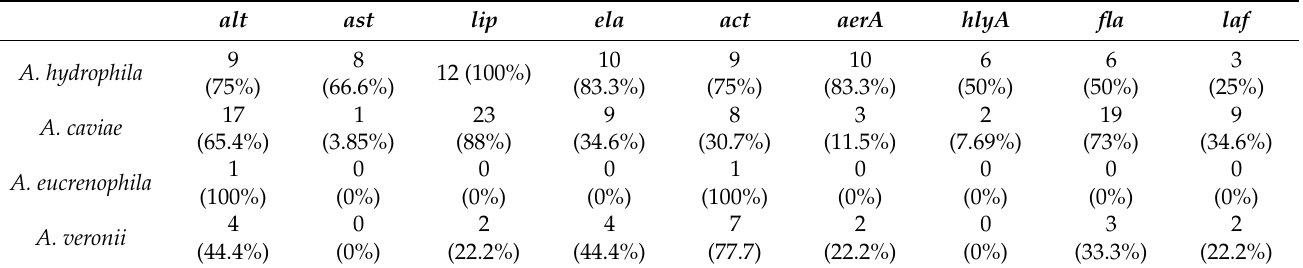
Table 1. Distribution of virulence genes (total strains n, %) among four isolated Aeromonas species.